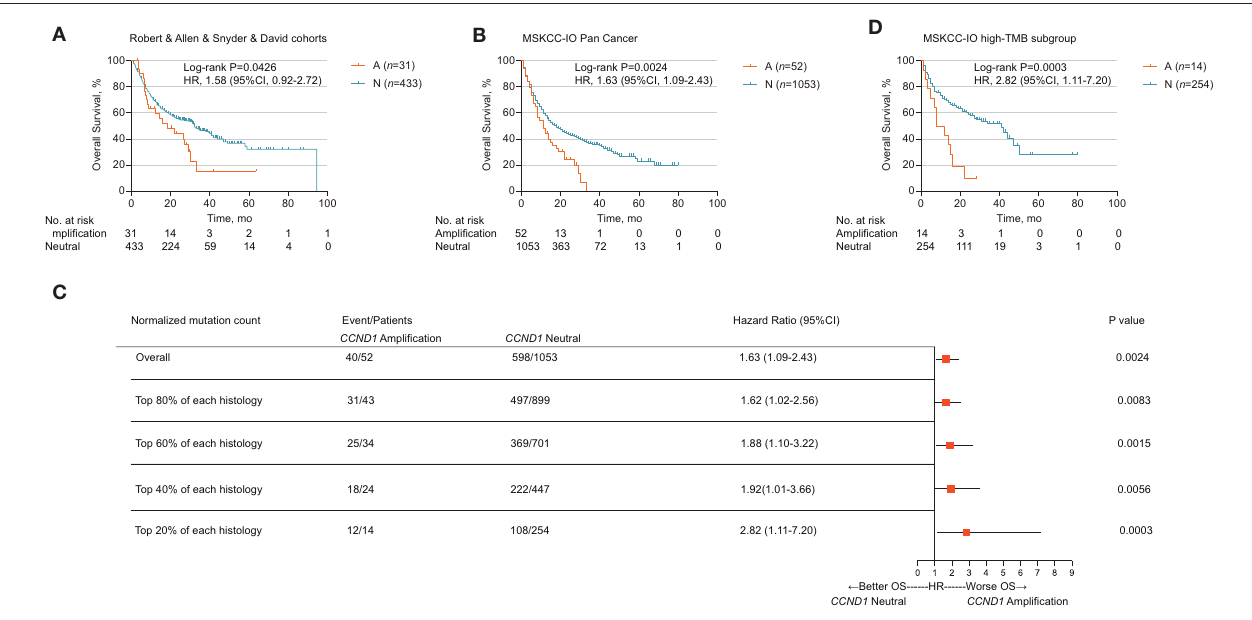
for TMB, cancer type, age, drug class of ICI, and the year of ICI start ( Table S4